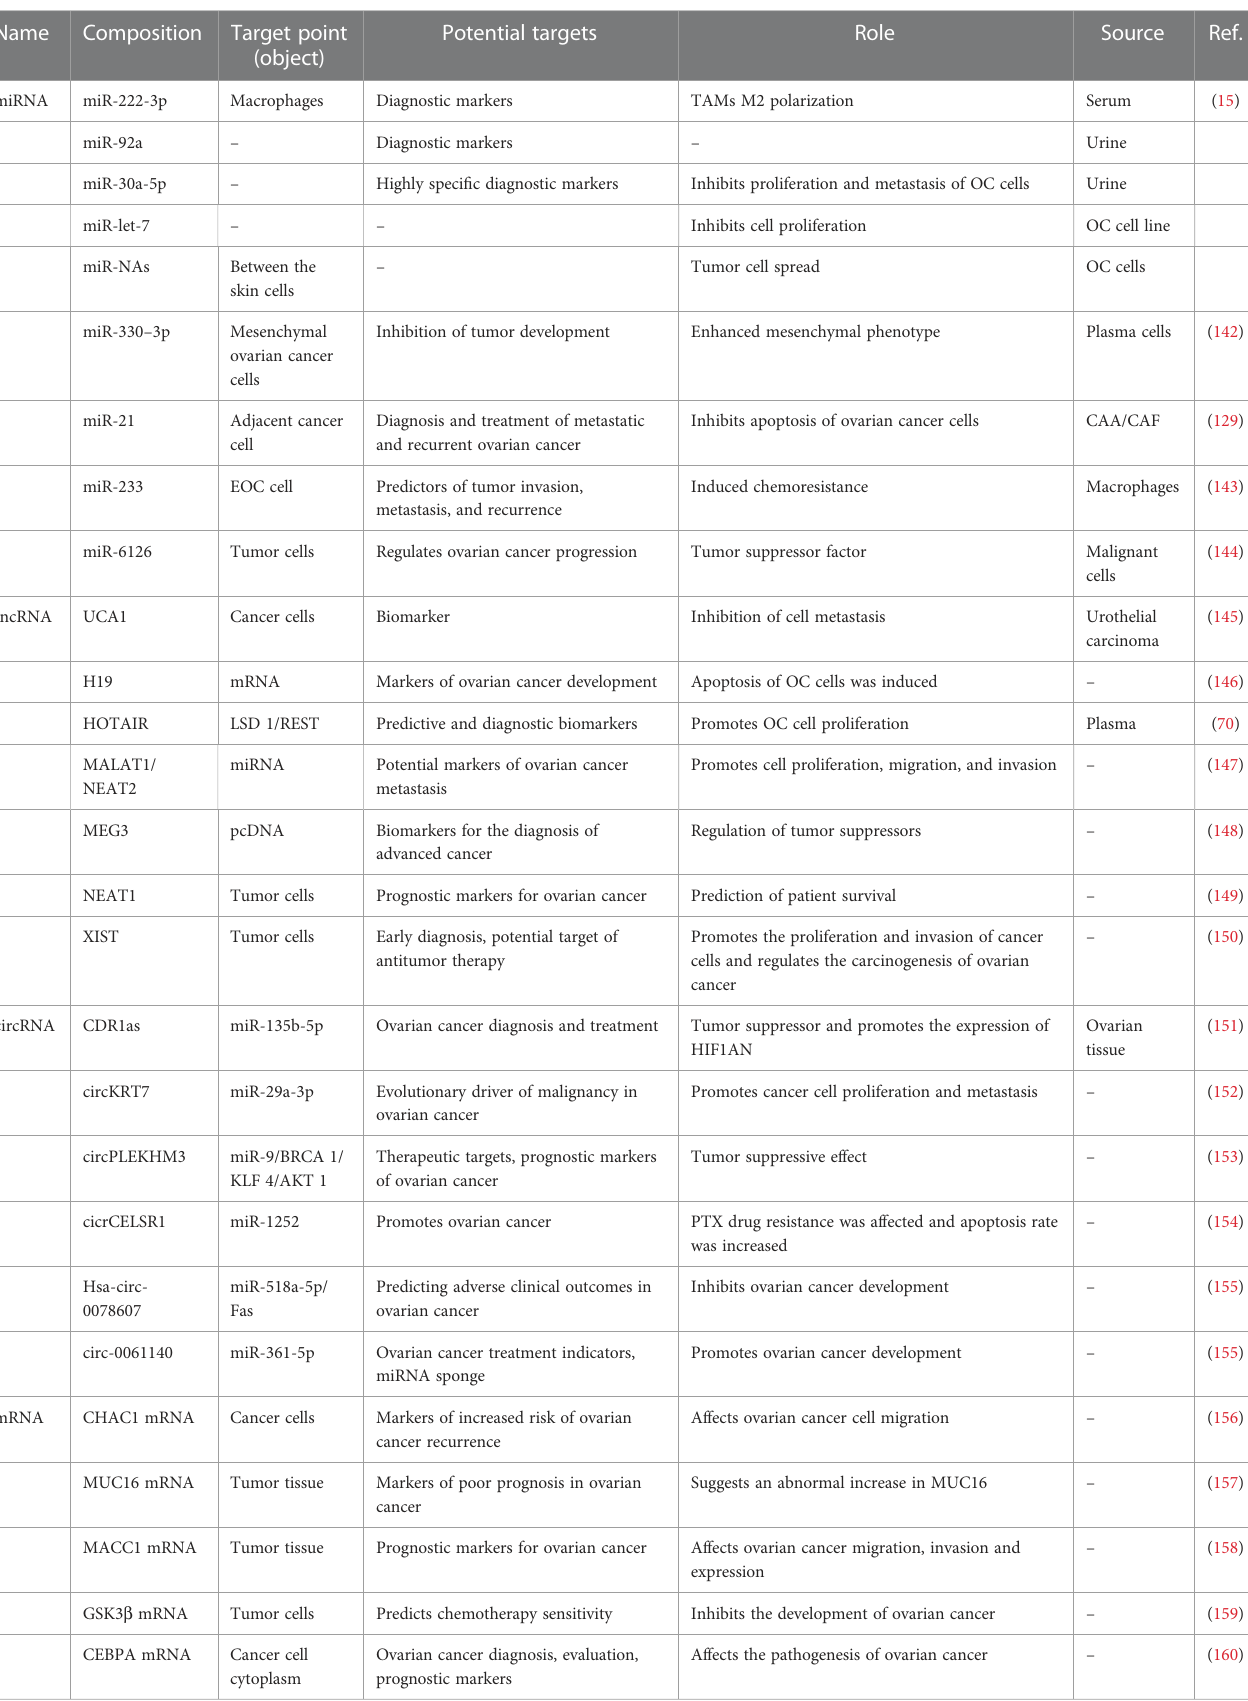
TABLE 2 Genes associated with immunotherapy in ovarian cancer.